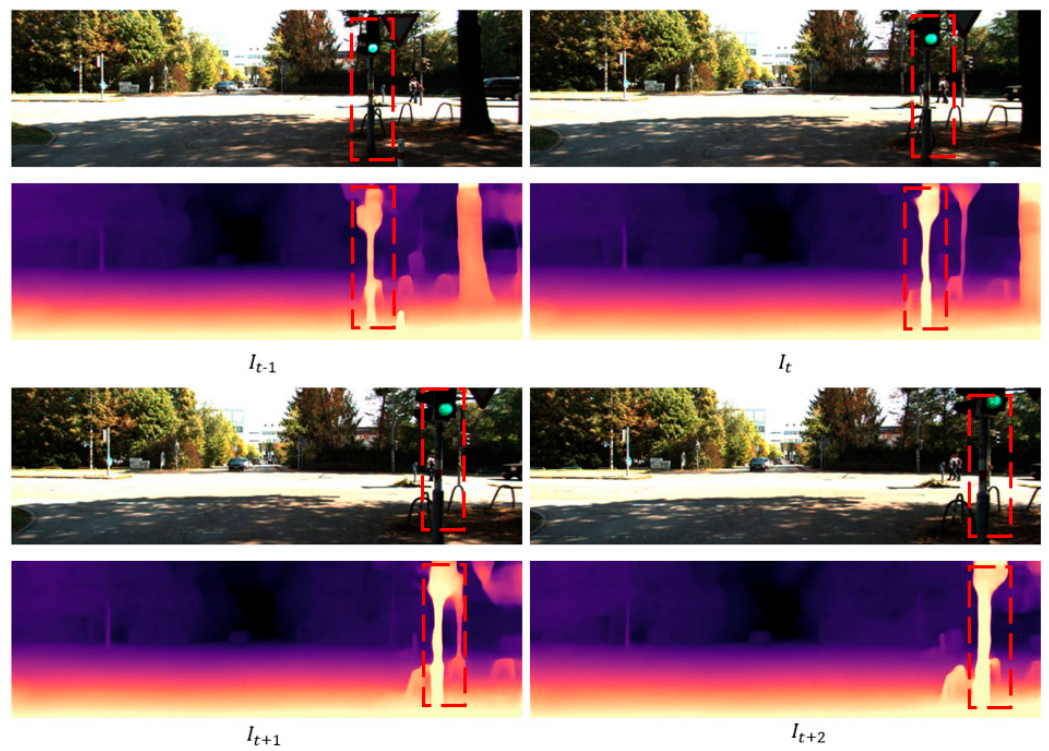
Figure 4. The result graph of the algorithm of the two adjacent frames.